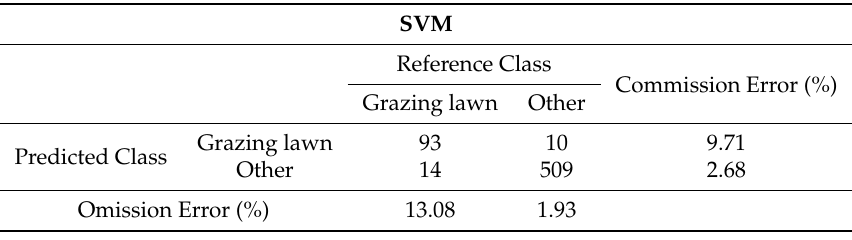
Table A7. Confusion matrix summarising results from Support Vector Machines (SVM) model classification of grazing lawn and other